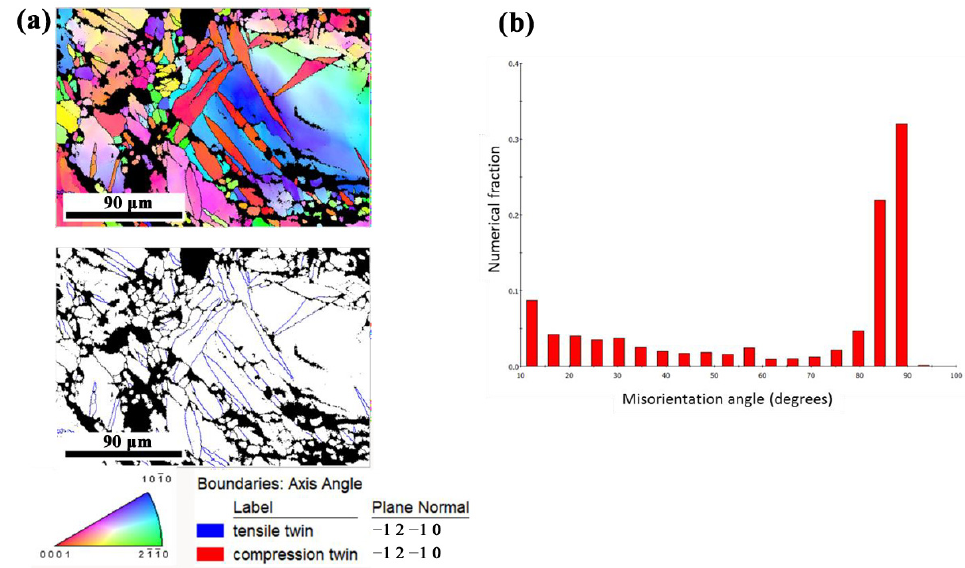
Figure 8. ( a ) EBSD inverse pole figure of forged ZK60EF-250 alloy; ( b ) misorientation angle plot for forged ZK60EF-250 alloy.